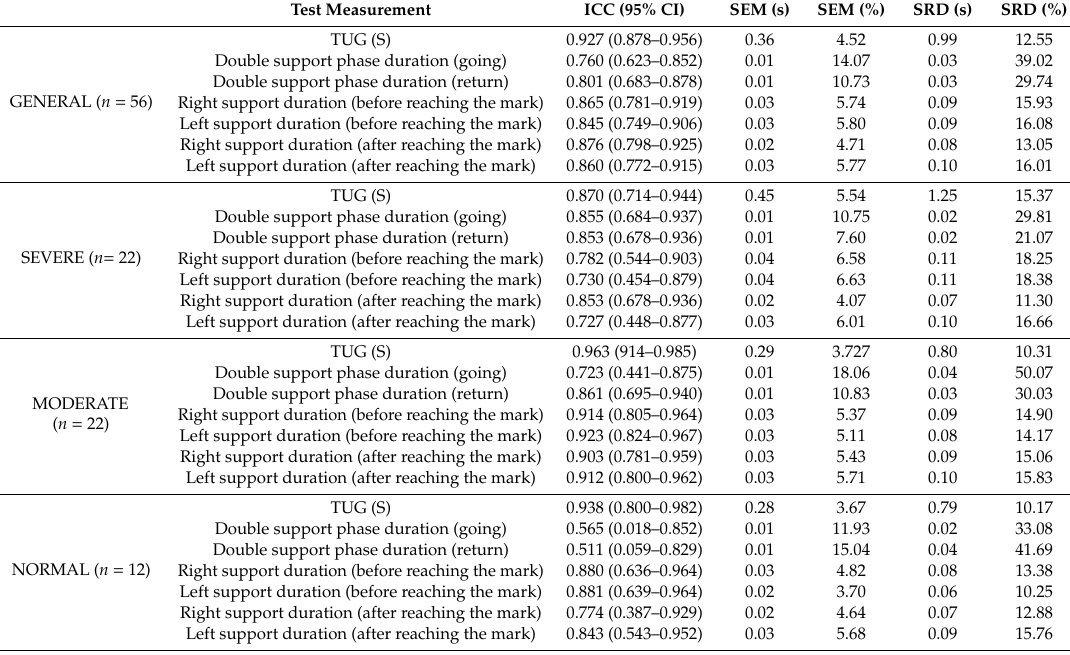
Table 3. Test-retest analyses of the duration of the walking phases in the entire sample and in participants with (a) severe neuropathy, (b) moderate neuropathy and (c) normal perception.